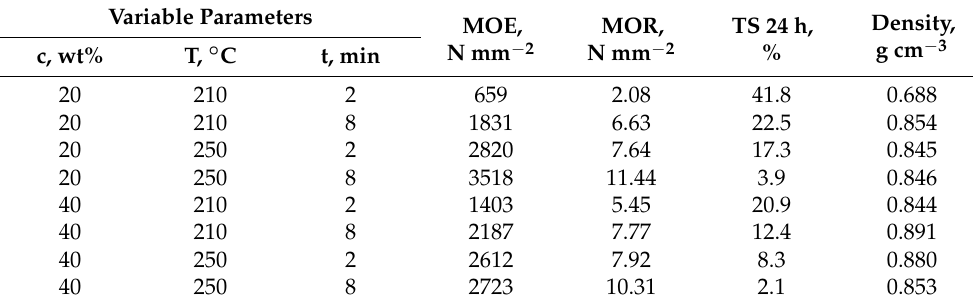
Table 8. Properties of particle boards, depending on the hot-pressing parameters.